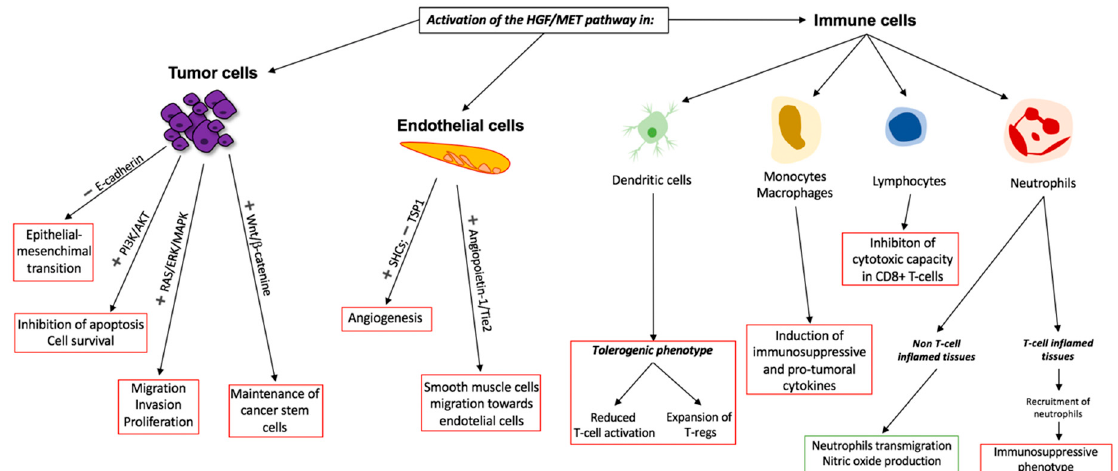
Figure 1. Role of the activation of the HGF / MET axis in tumor cells, endothelial cells, and immune cells. Red boxes define pro-tumorogenic functions. Green boxes define anti-tumorogenic functions. PI3K, phosphoinositide 3-kinase; ERK, extracellular signal-regulated kinase; MAPK, mitogen-activated protein kinase; SHCs—SRC homology 2 domain-containing proteins; TSP1—thrombospondin 1; Tie2—angiopoietin receptor 2.